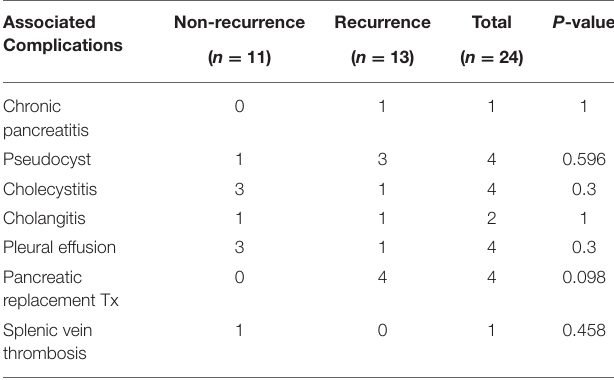
TABLE 6 | Pancreatitis-related complications and pathologies, stratified by patient group. Associated